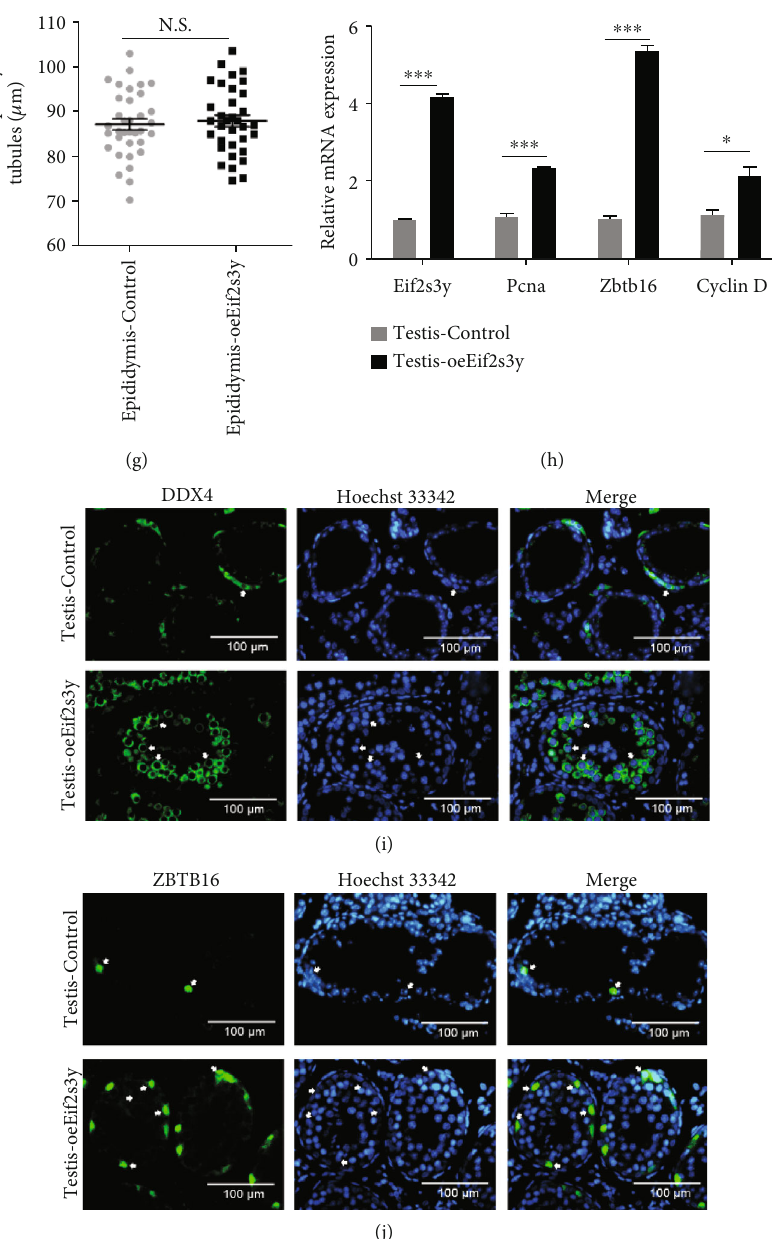
Figure 5: Eif2s3y promotes the colonization of goat SSCs in SSCT. (a) OeEif2s3y or Control SSCs were injected into the seminiferous tubules of busulfan-treated mice. The fi gure here shows two typical pictures of the testis during injection. Scale bars, 1mm and 5 mm as indicated. (b) Morphology of testes and epididymides transfected with oeEif2s3y or Control SSCs. (c) The testicular (left) and epididymis (right) weight/body mass ratio in two groups. (d) H&E staining of the mouse testis 30 days after injection. Scale bars, 50 μ m (left) and 20 μ m (right). (e) Statistical plots of the diameter of seminiferous tubules (left) and the thickness of seminiferous epithelia (right) from oeEif2s3y and Control SSC-transplanted mice. Each group counted at least 30 round seminiferous tubules from 10 mice. (f) H&E staining of the mouse epididymis 30 days after injection. Scale bars, 50 μ m (left) and 20 μ m (right). (g) Statistical plots of the diameter of epididymis tubules from oeEif2s3y and Control SSC-transplanted mice. Each group counted at least 30 epididymis tubules from 10 mice. (h) RT-PCR analysis of the expression of Eif2s3y , Pcna , Zbtb16 , and Cyclin D in Testis-Control and Testis- oeEif2s3y . (i) Immuno fl uorescence staining of DDX4 (green) in SSC-transplanted testes. The nuclei were stained with Hoechst 33342 (blue). Scale bar, 100 μ m. These white arrows represented typical DDX4-positive germ cells. DDX4 is a representative marker for pan-germ cells. (j) Immuno fl uorescence staining of ZBTB16 (green) in SSC-transplanted testes. The nuclei were stained with Hoechst 33342 (blue). Scale bar, 100 μ m. These white arrows represented typical ZBTB16-positive spermatogonial stem cells. ZBTB16 is a representative marker for undi ff erentiated spermatogonia. Data are presented as mean ± SD and are represented by three independent repetitions; ∗ P < 0 : 05 , ∗∗ P < 0 : 01 , and ∗∗∗ P < 0 : 001 ; N.S. means P ≥ 0 : 05